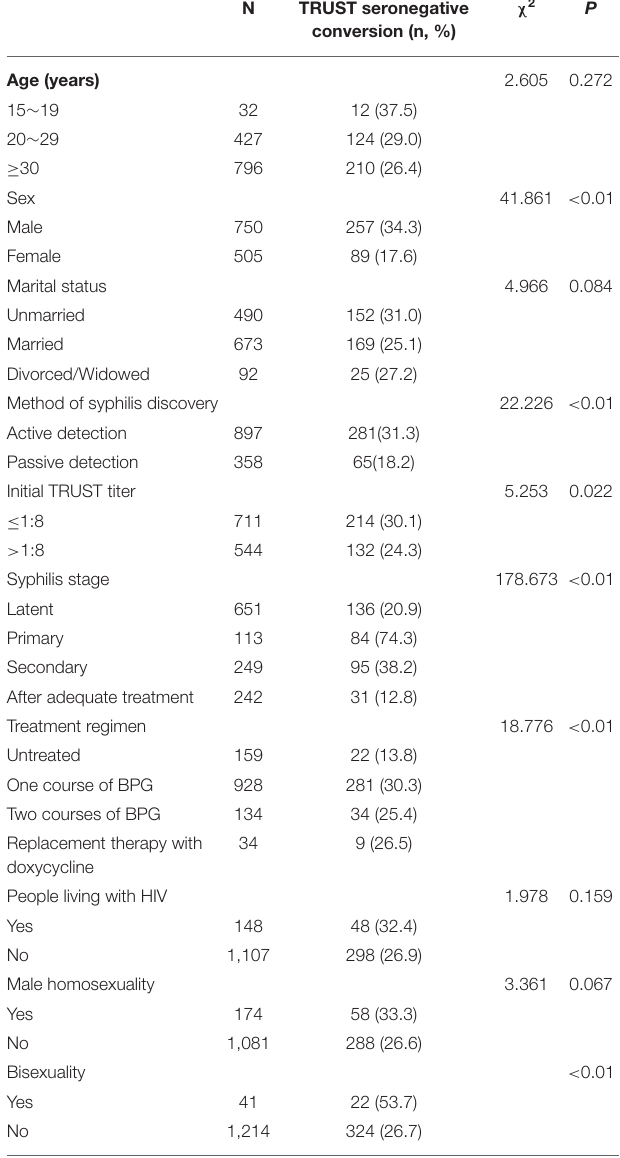
TABLE 1 | Outcomes of TRUST seronegative conversion among syphilis